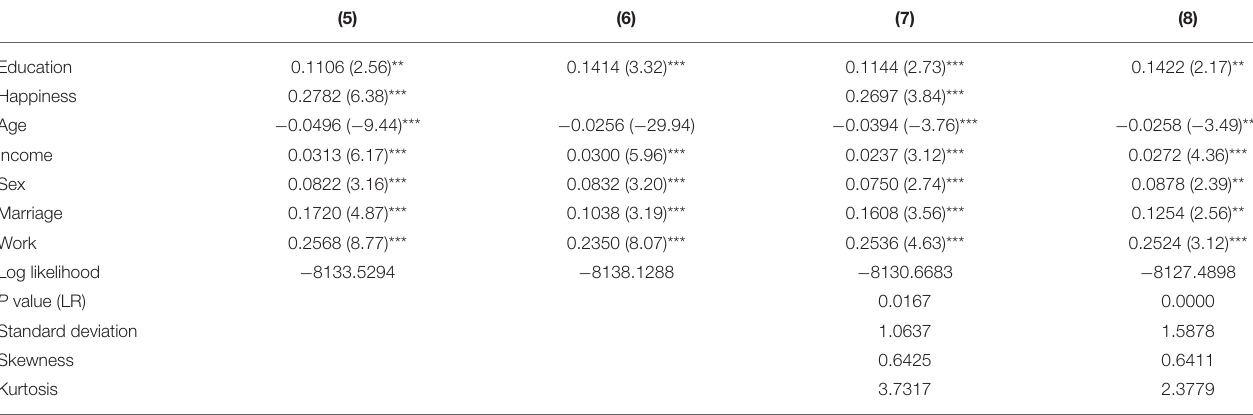
TABLE 3 | The mechanism test based on the new method.